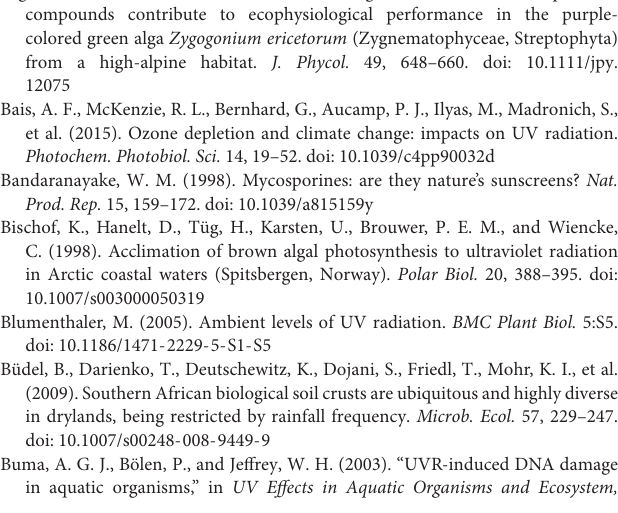
FIGURE S3 | (A–E) NMR Spectra of Klebsormidin B recorded in D 2 O. FIGURE S4 | (A–E) NMR Spectra of Klebsormidin A recorded in D 2